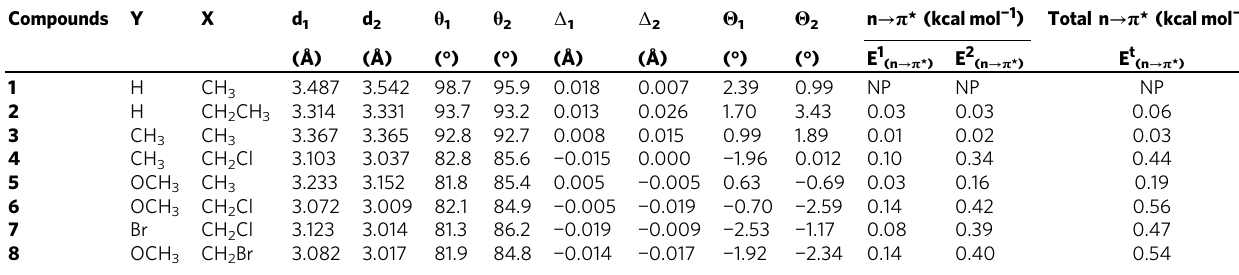
Table 1 X-ray crystallographic structural parameters and NBO data for compounds 1 – 8 Compounds